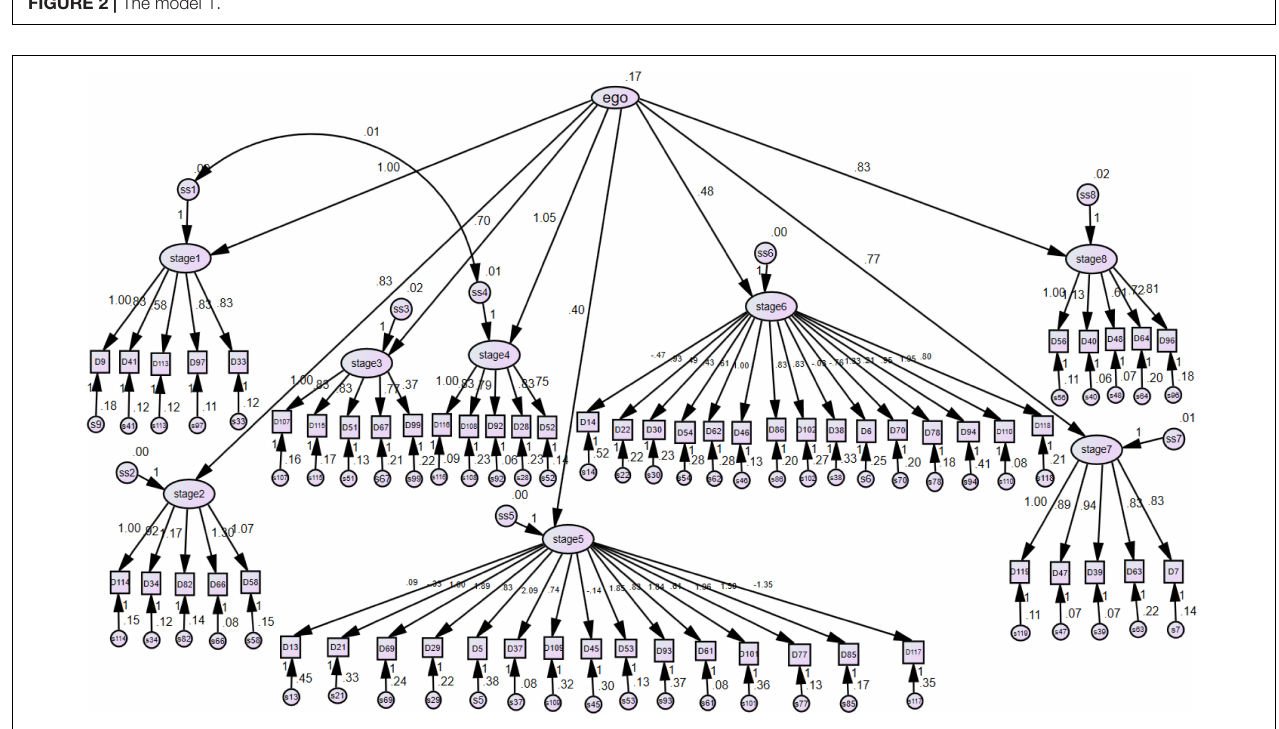
FIGURE 2 | The model 1.